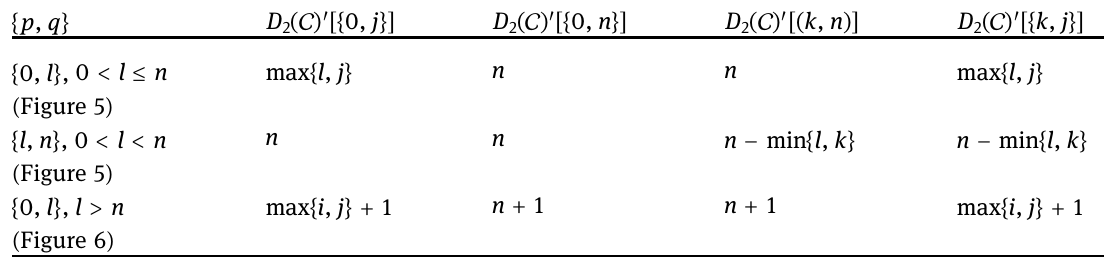
Figure 5: Minimum subgraph of C containing vertices {